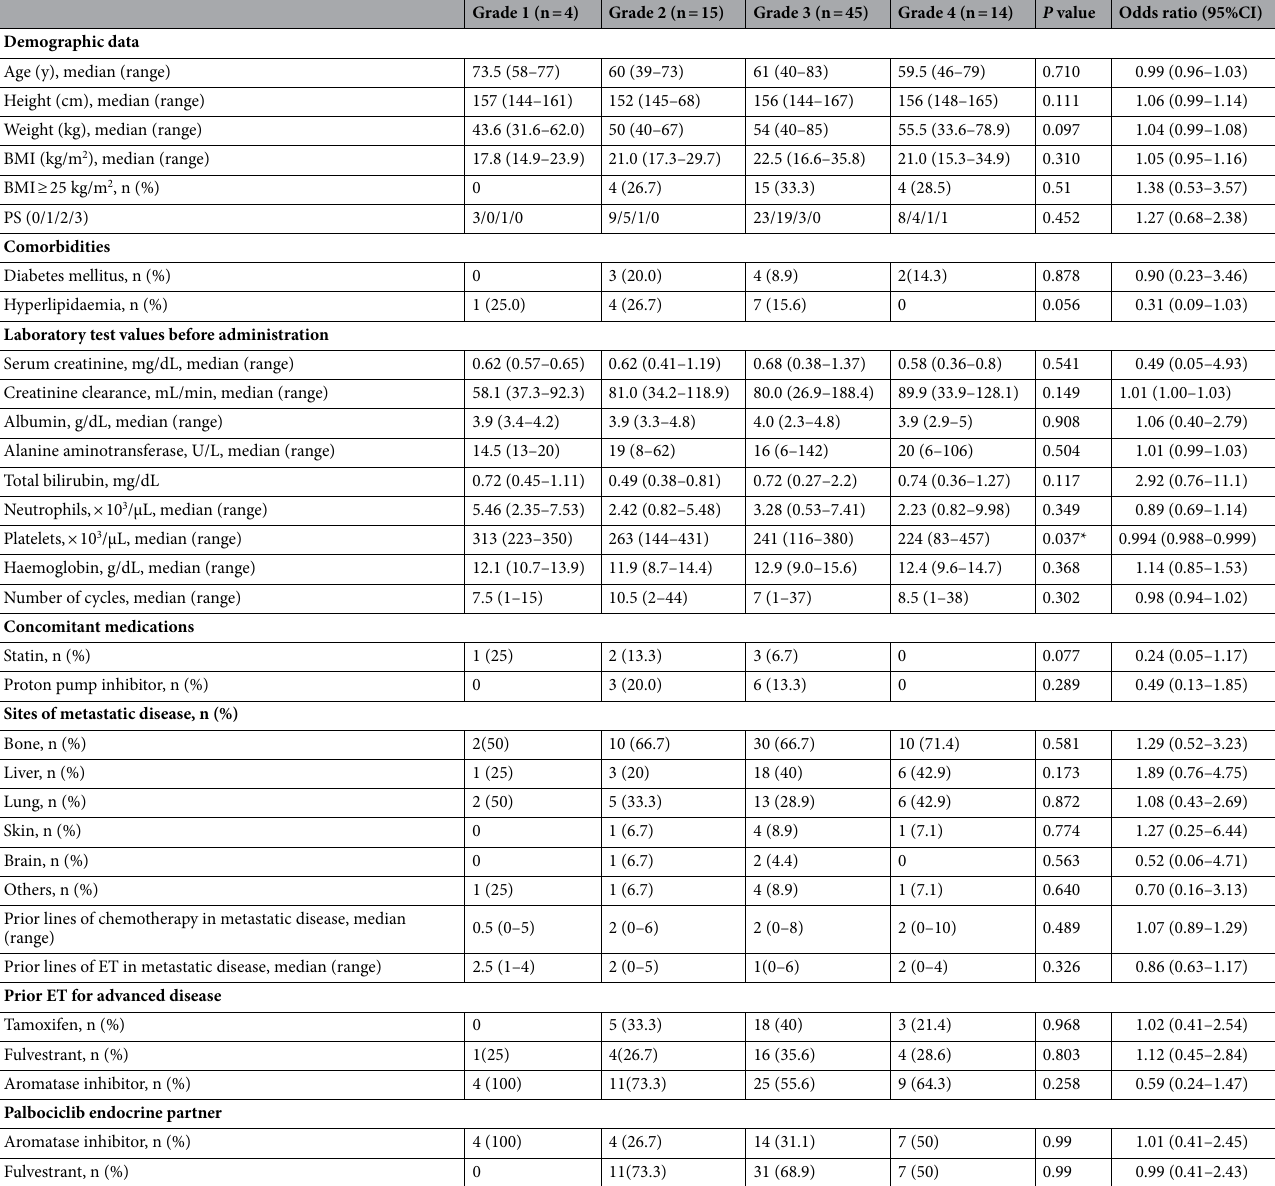
Table 1. Patient characteristics, extracted variables, and results of univariate analyses (n = 78). CI, confidence interval; BMI, body mass index; PS, ECOG performance status; ET, Endocrine therapy. * P <